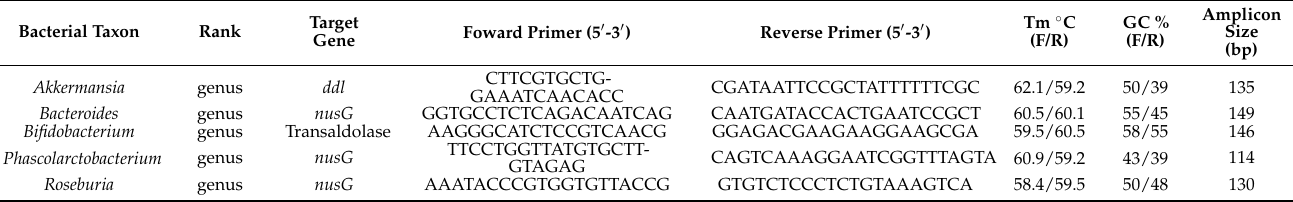
Table 1. Overall information of bacterial genus-specific primer